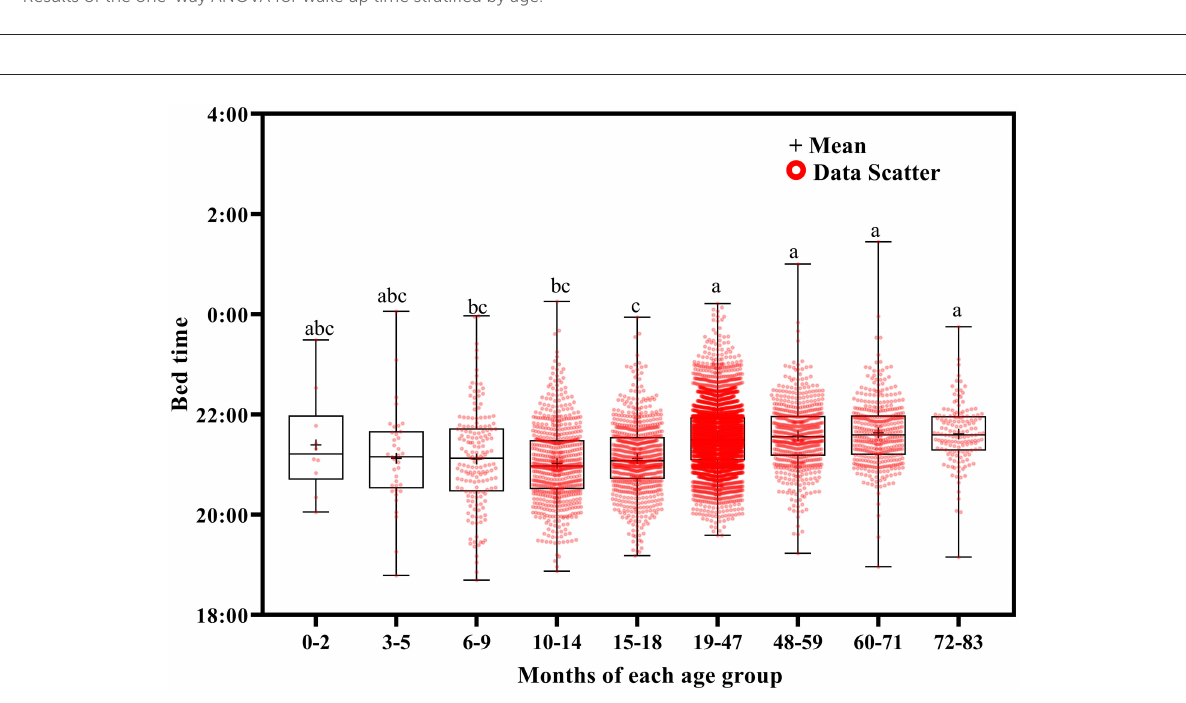
FIGURE3 Results of the one-way ANOVA for bed time stratified by